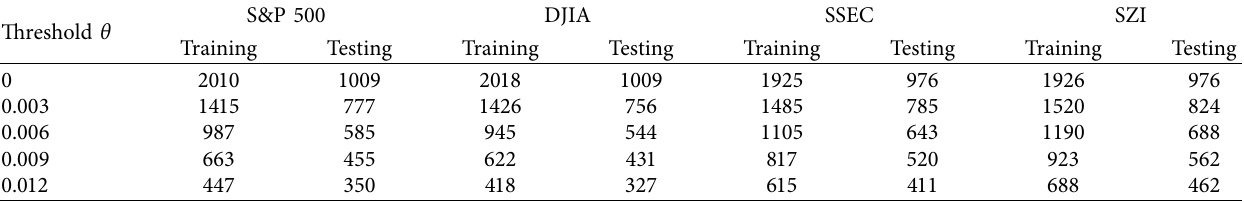
Table 2: Numbers of data distributed in training data and testing data under different threshold values θ